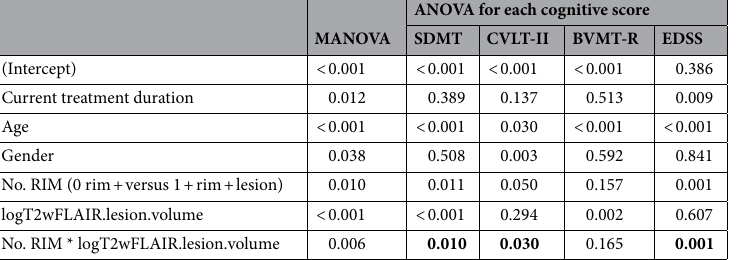
Table 2. Summary of p-values from the Multivariate Analysis of Variance (MANOVA) table and subsequent Analysis of Variance (ANOVA) tables for each score. The final multivariate model for SDMT, CVLT-II, BVMT-R, and EDSS as vectors of response variables included current Treatment Duration, Age, Gender, No. RIM of + lesions, log T2wFLAIR lesion volume, and the interaction term No. RIM * logT2wFLAIR. lesion.volume as covariates. This report gives the p-values associated with the MANOVA Pillai test and the approximated F-statistics for each score (ANOVA). The bolded values represent the significant association of the interaction term (No. RIM * logT2wFLAIR.lesion.volume) with the clinical outcomes.